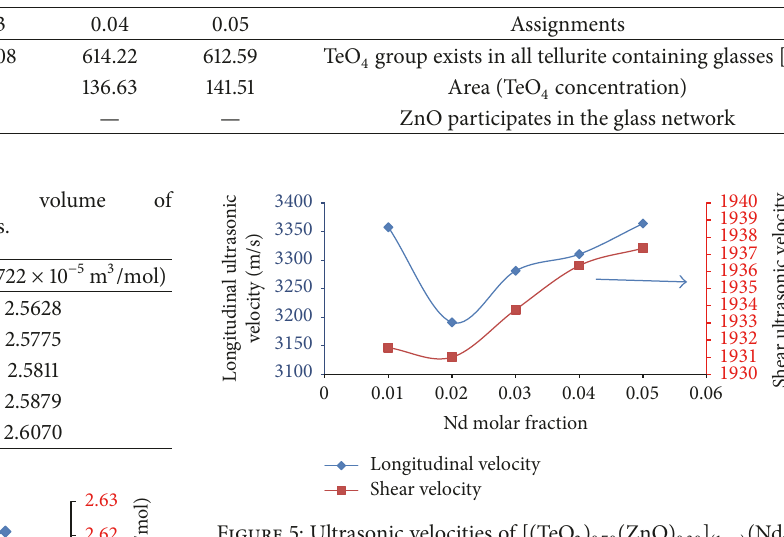
Table 1: Assignment of infrared transmission bands of the prepared glass sample with different concentrations of lanthanum neodymium oxide nanoparticles.